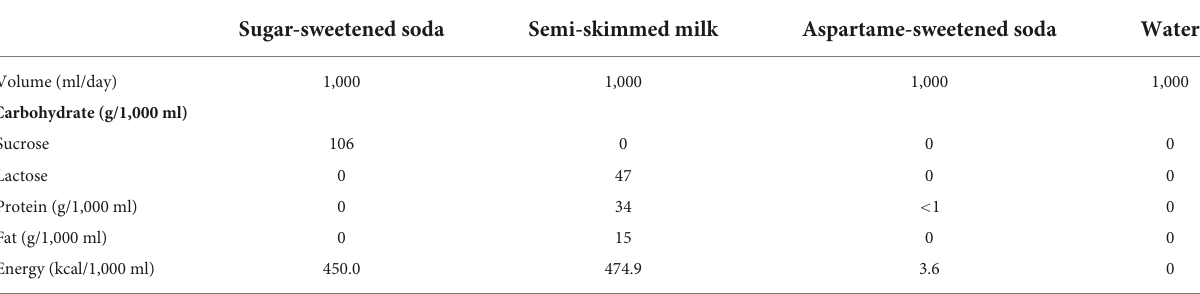
TABLE 2 Composition of the test